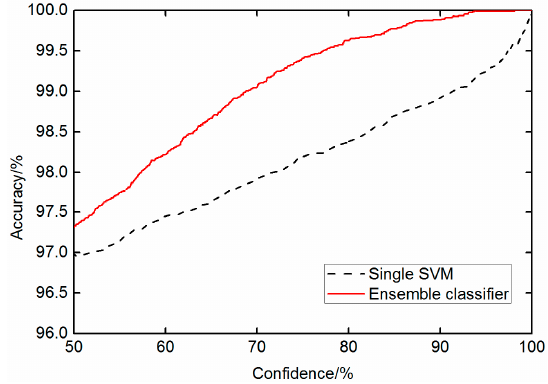
Figure 15. Confidence ‐ Accuracy curves of different classifiers.